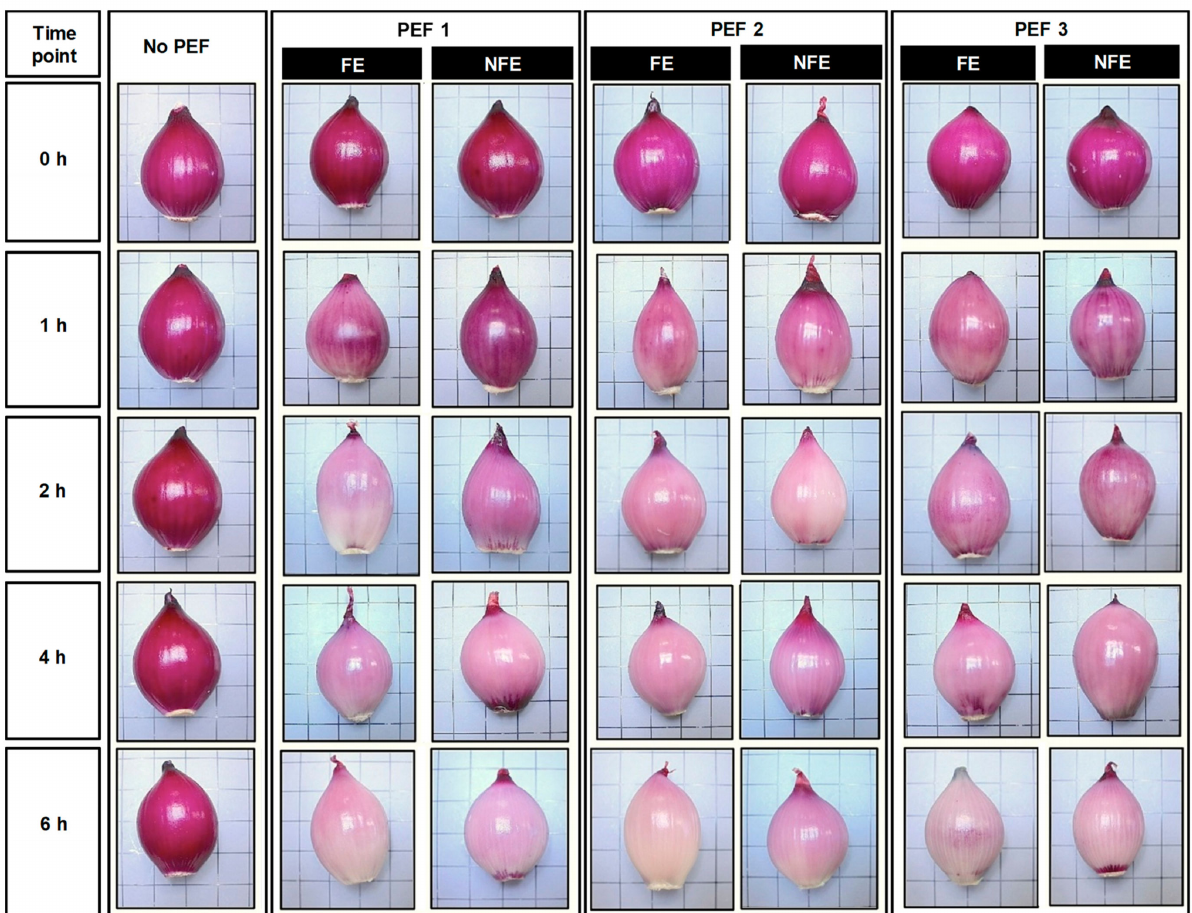
Figure 3. Representative photographs of untreated and PEF-treated onion bulbs over the course of 6 h after PEF application. The onion bulb was positioned with either the root end facing the electrode (FE) or the root end not facing the electrodes (NFE) at the time of PEF application, then suspended in the sodium phosphate bu ff er (0.01 M, pH 7) and removed at a predetermined time point to capture the changes in the natural purplish-red pigment